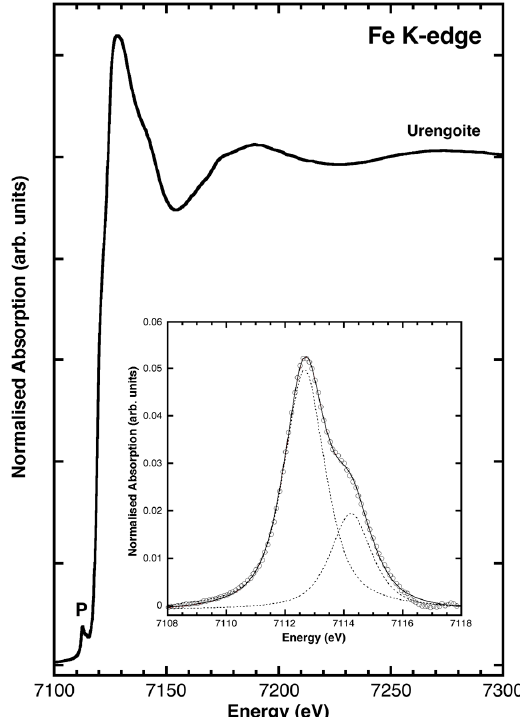
Figure 8. Fe K-edge XANES spectra of urengoite U1; background subtracted pre-edge peak (labeled P in the XANES spectrum) shown in the inset.